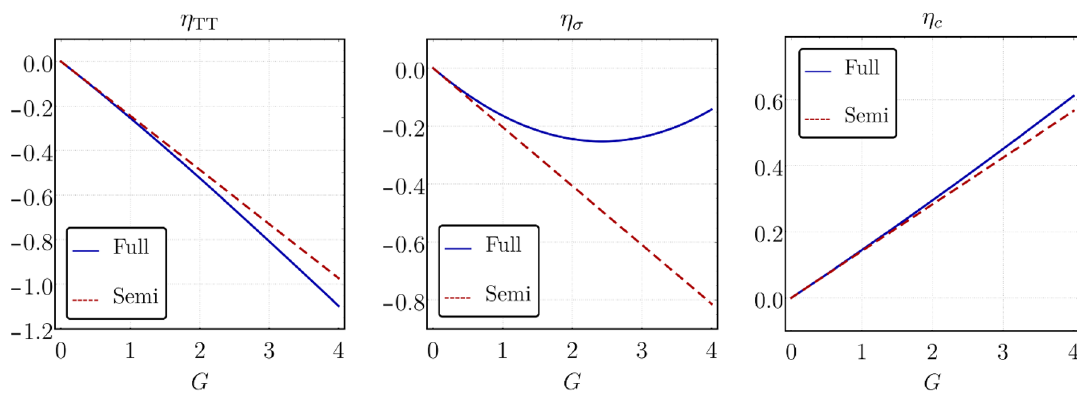
Figure 2 . We show the anomalous dimensions (cid:17) TT , (cid:17) (cid:27) and (cid:17) c , in terms of the dimensionless Newton’s coupling, in the case corresponding to m 2 result and the semi-perturbative